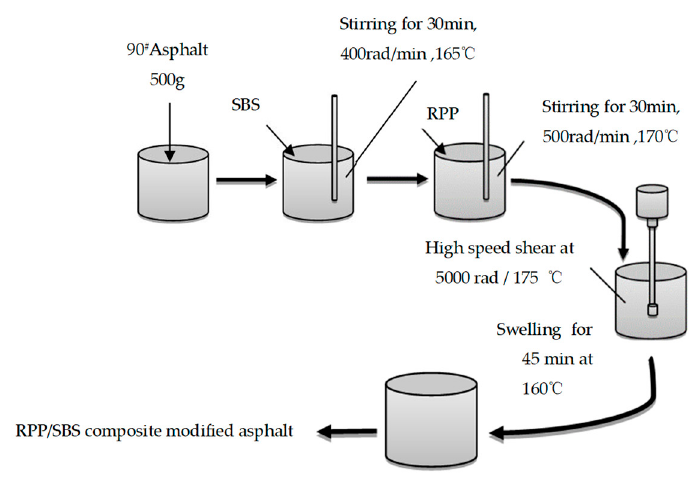
Figure 4. RPP/SBS composite modified asphalt preparation flow chart.